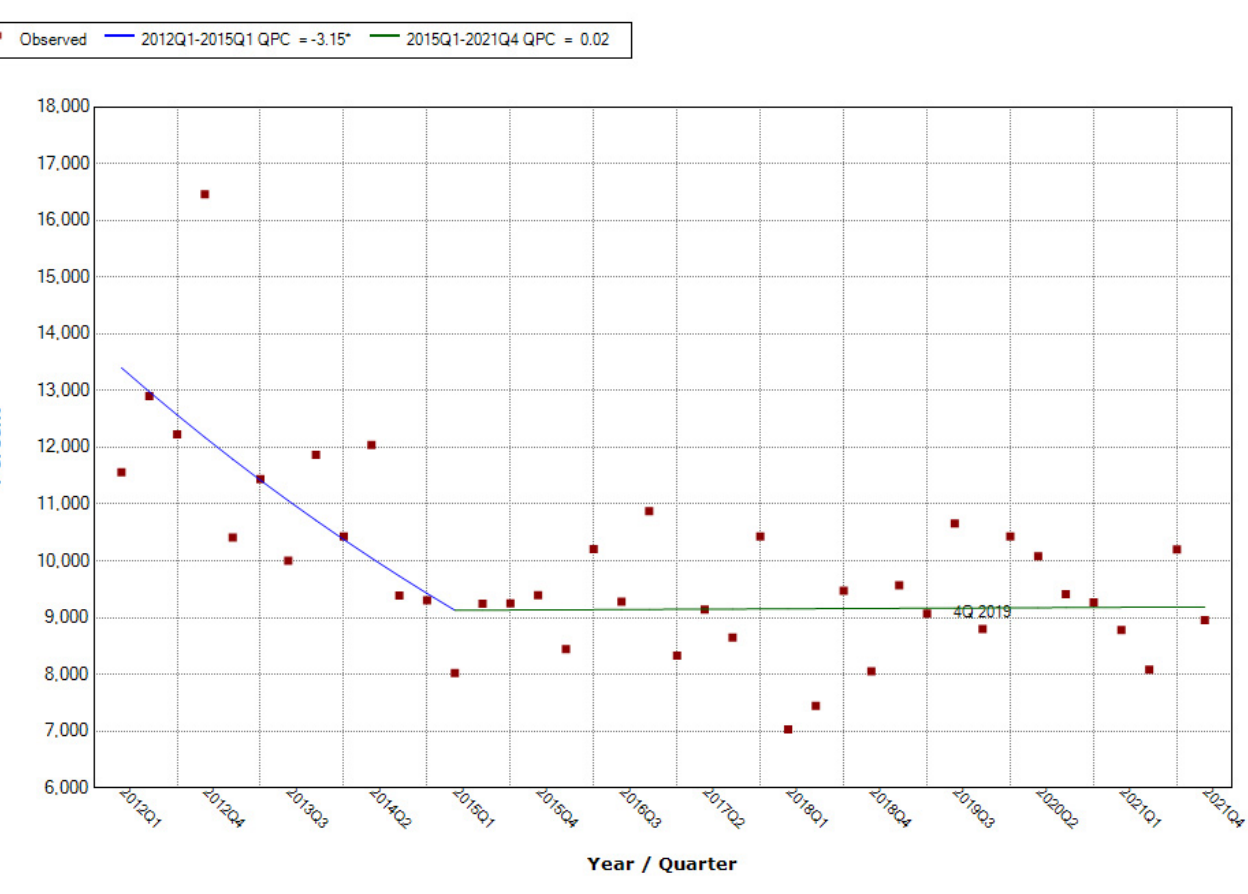
Figure A24. Percentage of products containing vitamin B1 in individual quarters in the period from 2012 to 28 November 2021. Joinpoints mark trend turning points. The date above the observation indicates the moment of publication of the scientific opinion/resolution.